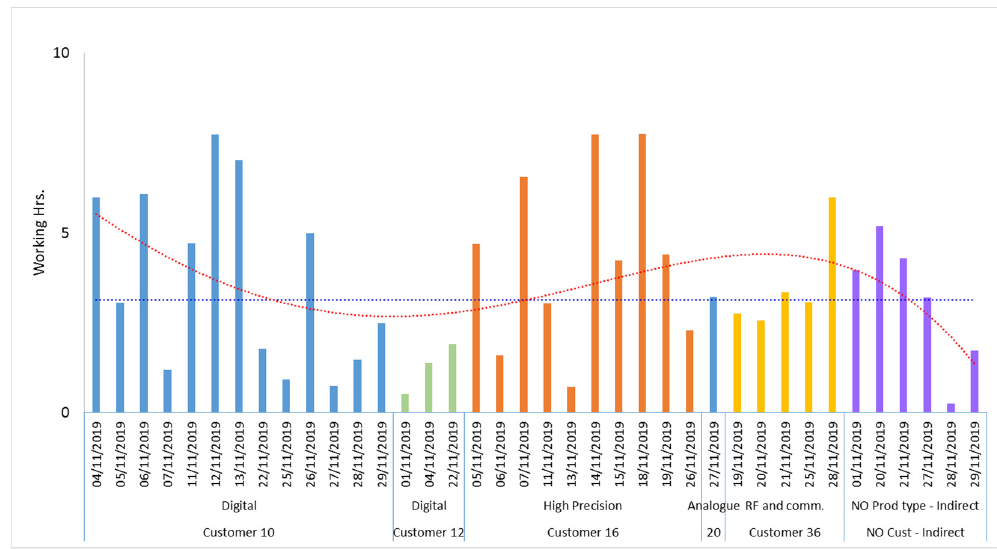
Figure 14. Test operator (TO) 15 (Engineer)—November 2019.